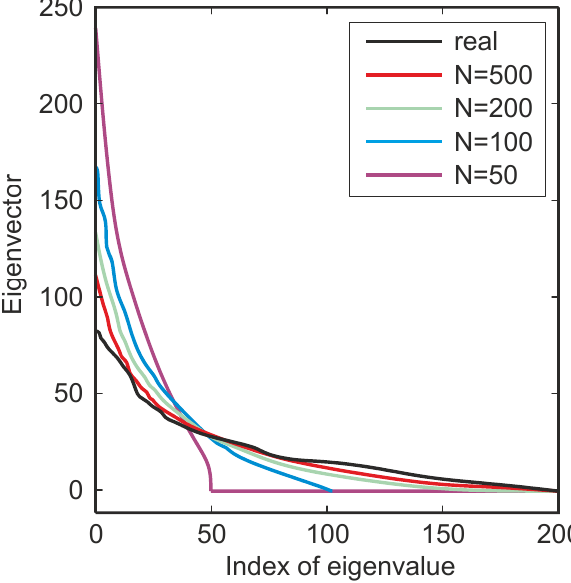
Figure 6. Eigenvalue spectrum of a given covariance matrix (bold line) and eigenvalue spectra of covariance matrices estimated from a finite number of samples ( N = 50, 100, 200, 500). Note that accuracy increases as the number of trials increase (adapted from